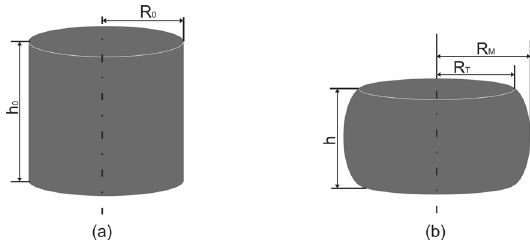
Figure 3. A simple representation of solid compression test and the measured parameters (a) before and (b) after